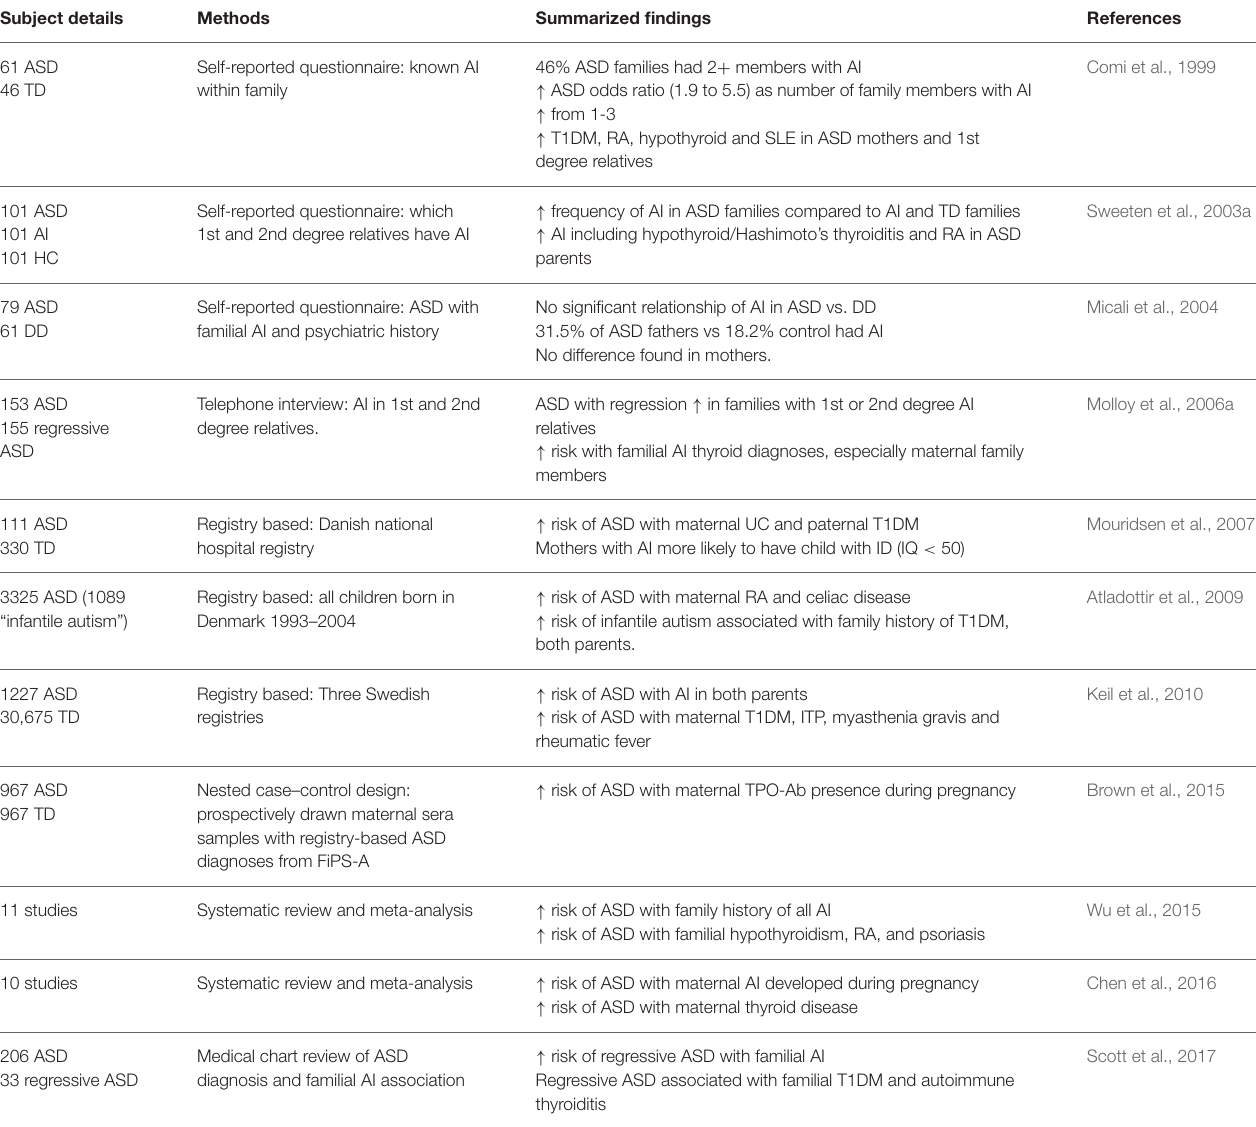
TABLE 1 | Studies identifying association of familial autoimmunity and